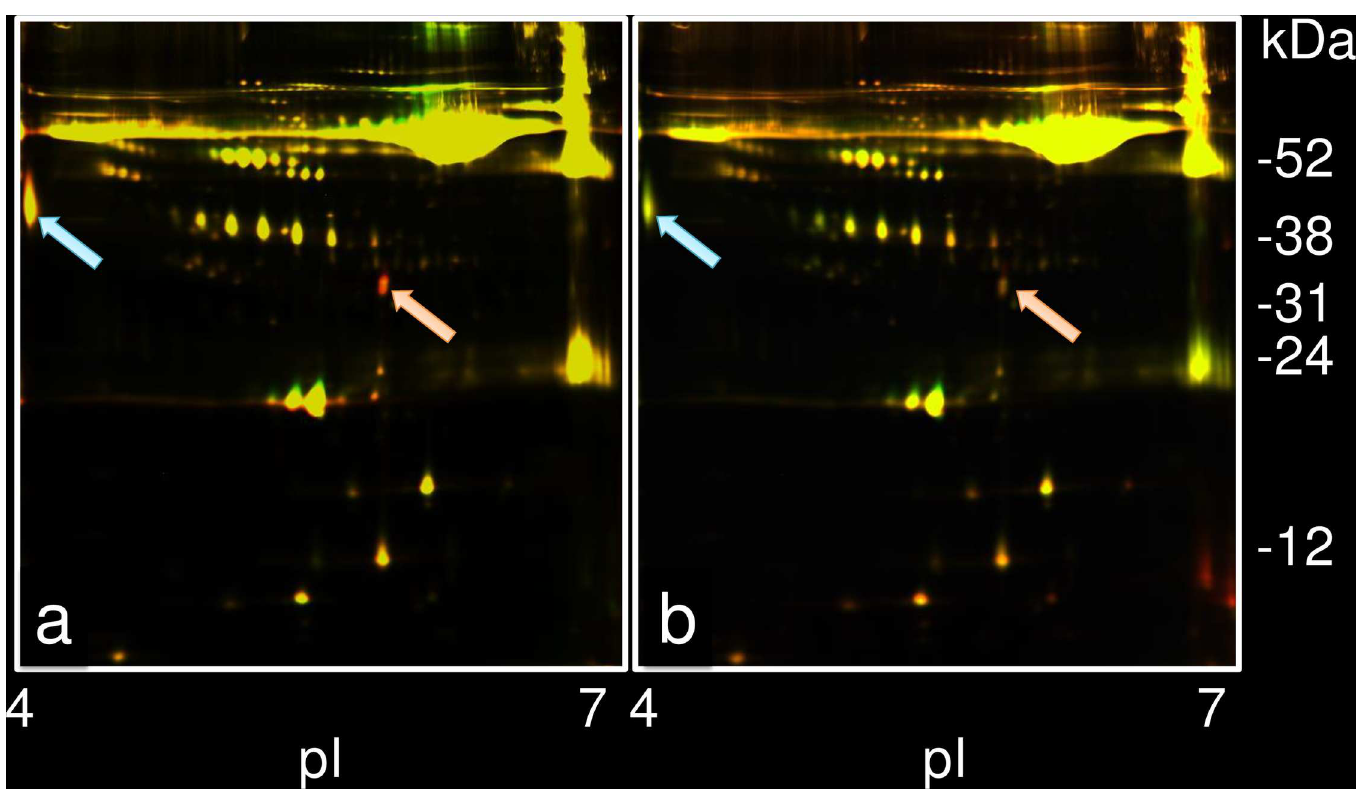
Fig 2. A representative result of 2D DIGE for a diver diving at 60 msw. (a) Differential expression of two plasma protein spots is shown for the hyperbaric conditionat 60 msw for 17 h compared with that before SD trainingin a healthy diver. The red spot, designated as the increasedexpression spot, was detected at 32.4 kDa, pI 5.8 (ratio; 2.33), and indicated by a pink arrow. The other reddishspot indicated by a light blue arrow was located at 44.8 kDa, pI 4.0 (ratio; 1.85). (b) Differential expressionof plasma protein spots pre- and post-SD training from the same diver. The 32.4-kDa spot decreasedto about the same level (ratio; 1.21) (indicated by a pink arrow). The expression of the 44.8-kDa protein decreasedto below pre-SD training level (ratio; -1.78), detected as a green spot (indicated by a light blue arrow).